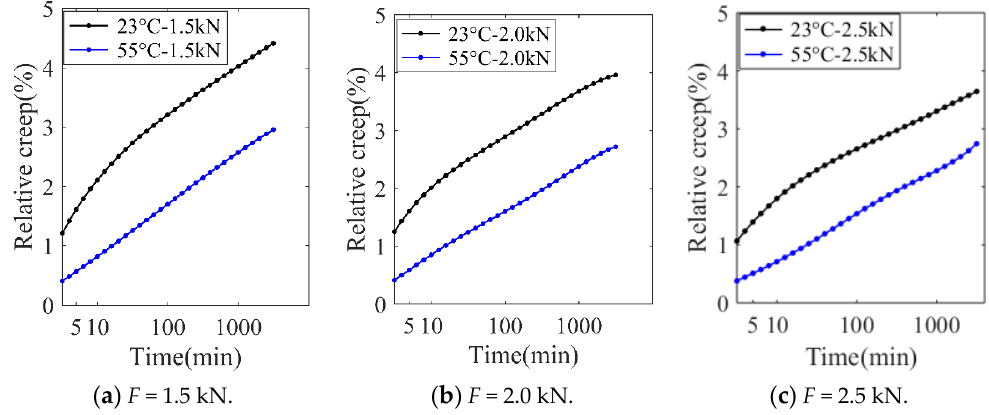
Figure 17. Creep rate for rubbers under different conditions.